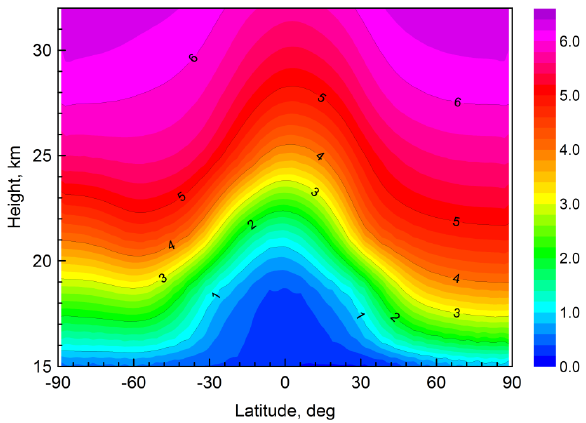
Fig. 3. Cross-Sections of the annual mean age of air (years) from Fig. 3. Cross-section of the annual mean age of air (years) from NIES TM simulations of SF 6 with 953 NIES TM simulations of SF 6 with JRA-25/JCDAS JRA-25/JCDAS reanalysis. 954